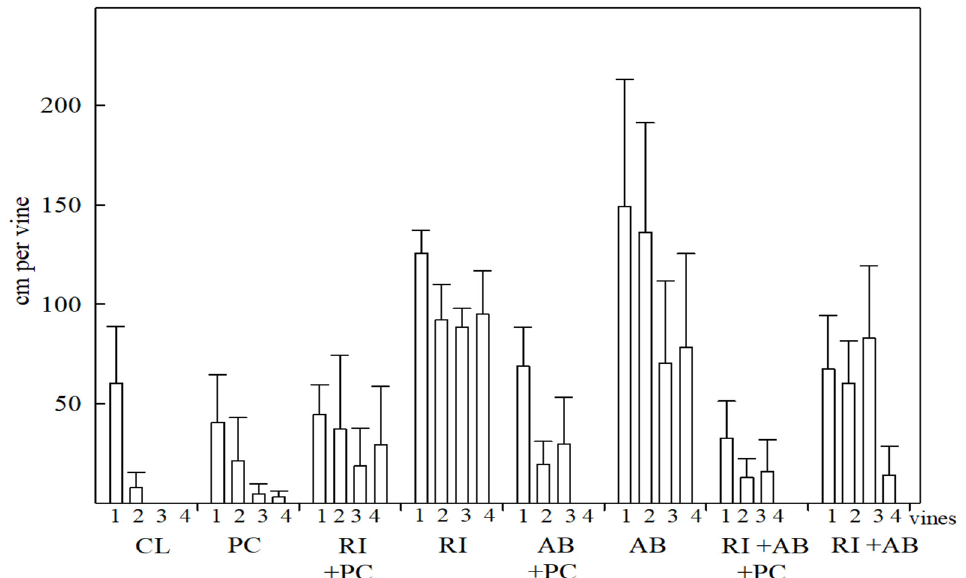
Figure 2. Length of vines in plant of S. edule var. virens levis Costa Rica Type due to the effect of biofertilization with R. intraradices and/or A. brasilense in interaction with P. capsici . Values at 84 DAP. The vertical line indicates ± the standard error.